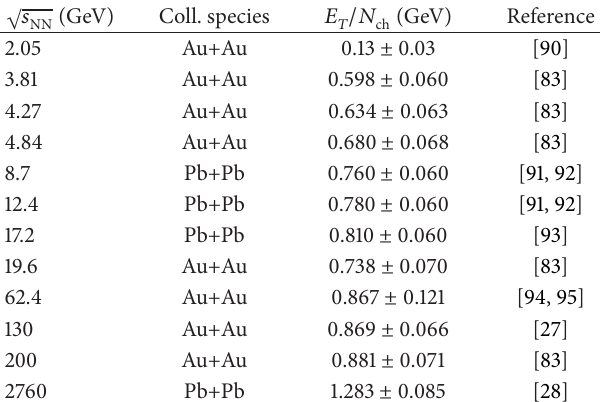
(GeV) as a function of √𝑠 ch